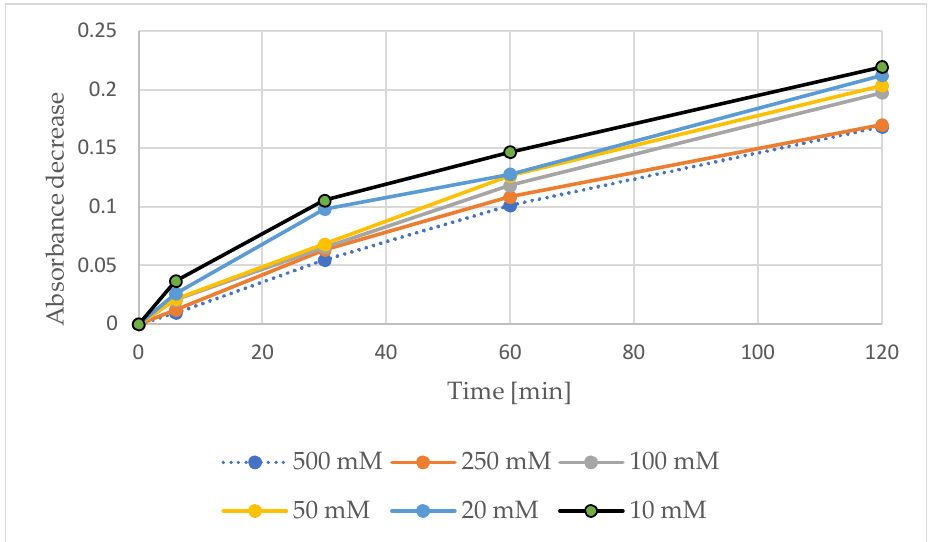
Figure 4. Reactivity of Trolox (5 nmoles) with ABTS • in buffers (100 mM) of various pH.